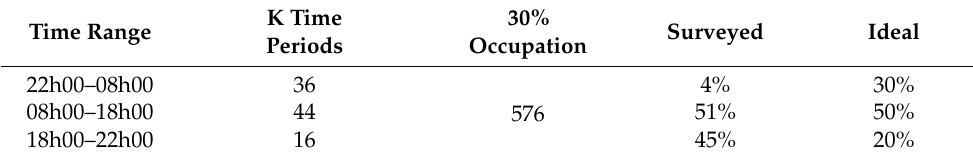
Table 4. Case with 30% occupancy of the charging bays.